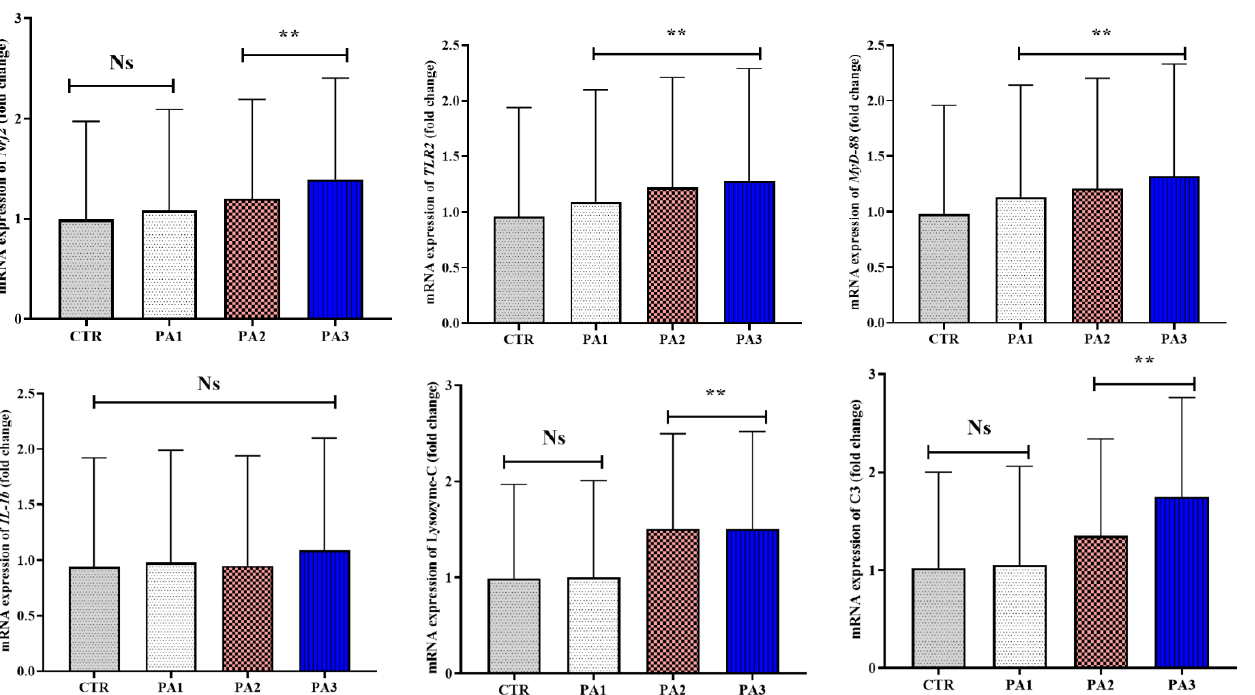
Figure 3. Intestinal-immune-related gene ( Nrf-2 , TLR-2 , MyD-88 , IL-1 β , lysozyme-C, C-3) expressions in common carp administered with P. australis extract at 0.0 (CTR), 100 (PA1), 200 (PA2) and 400 (PA3) mg/diet for 56 days. Data are presented as mean ± SE. Ns indicate no significant differences between groups, while ** indicates significance at 0.005 ( p < 0.05).